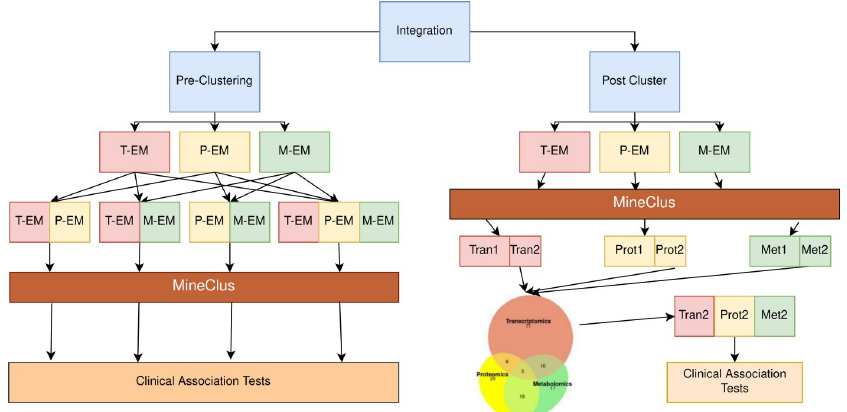
Fig 3. Flow chart for multi-omics pre- and post-clustering integration. T, P, and M, represent the Transcriptomic, Proteomic or Metabolomic data sets respectively. Tran, Prot, and Met represent the Transcriptomic, Proteomic or Metabolomic subtypes respectively. 1 and 2 signify the large or small subtype respectively.